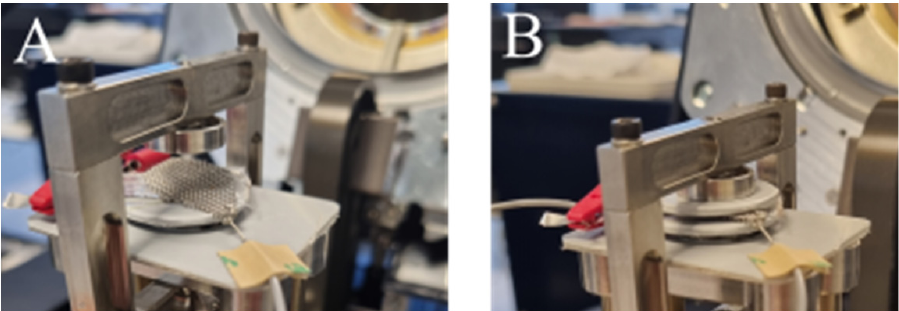
Figure 2. Experiment schematic of PVC-gel actuator. ( A ) PVC-gel actuator loaded with only electro- static force. ( B ) PVC-gel actuator loaded with both mechanical force and electrostatic force.